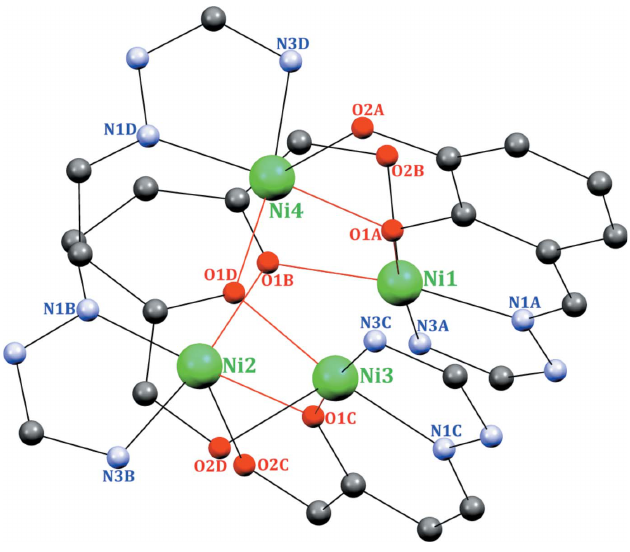
Figure 2 Ball-and-stick figure of the tetranuclear nickel complex, illustrating the coordination sphere about the nickel centres.